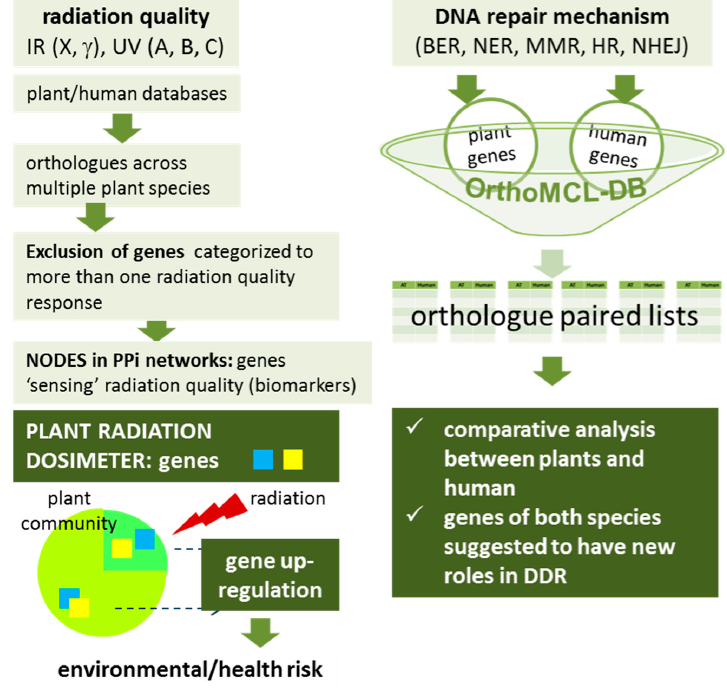
Figure 12. Schematic representation of the in silico methodology designed to select candidate genes for the plant radiation dosimeter as well as for the comparison of human and plant DNA repair machinery. BER, base excision repair. NER, nucleotide excision repair. MMR, mismatch repair. HR, homologous recombination. NHEJ, non-homologous end joining. DDR, DNA damage response. IR, ionizing radiation, UV, ultraviolet radiation. PPi, protein-protein interaction. Please see recent work by Pateras et al. [20], for analytical description of all DDR pathways.